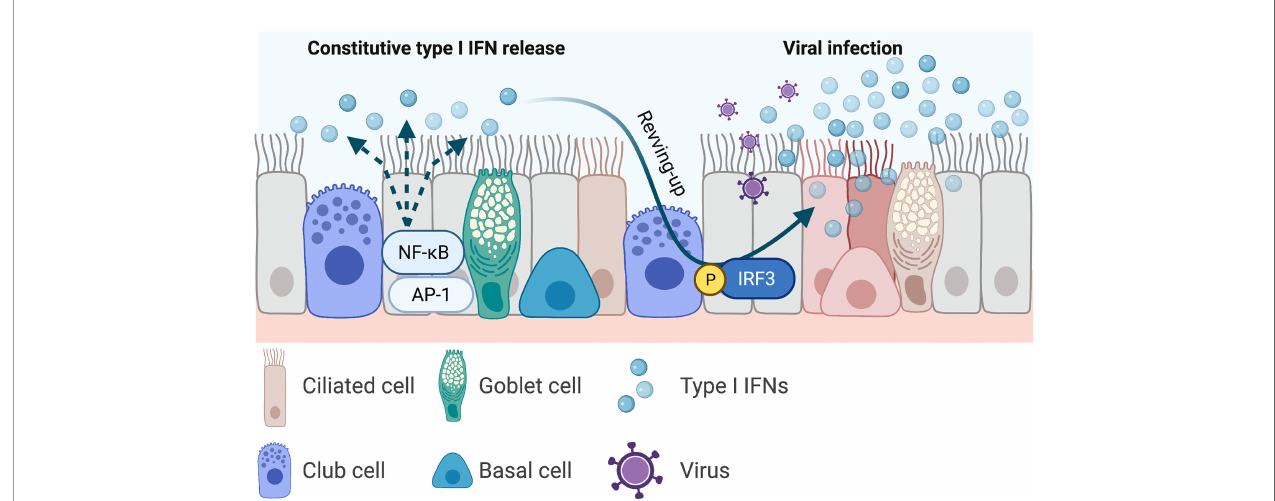
FIGURE 2 | Constitutive type I interferons and the revving-up model. Airway epithelial-derived type I interferons (IFNs) are constitutively expressed and primes the local microenvironment at resting state. This priming mediates a more robust antiviral responses upon viral infection. Current evidence shows that the constitutively expressed type I IFNs are driven by the transcription factors nuclear factor kappa-light-chain-enhancer of activated B cells (NF- k B) and activating protein (AP)1. Infection induced type I IFNs are mediated by the transcription factor IFN regulatory factor (IRF)3. Increased production of type I IFNs restrict viral replication. This fi gure was created with